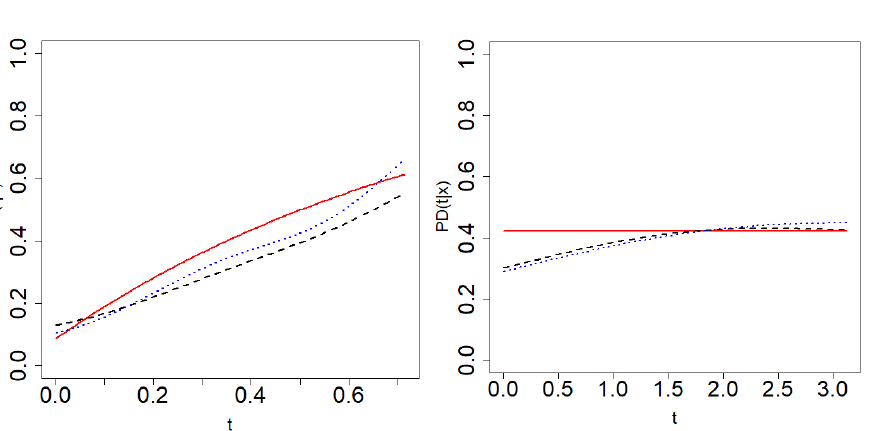
Figure 6. Boxplot of H ∗ conditional probability of censoring is 0.2 ( left ) and 0.5 ( right ) in Model 2.